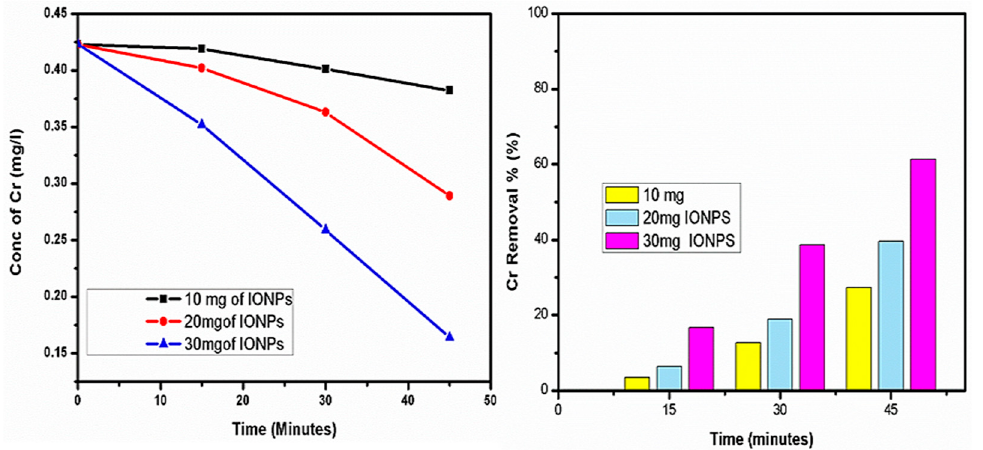
Figure 6. Removal % of Cr using IONPs at different concentrations and their removal.